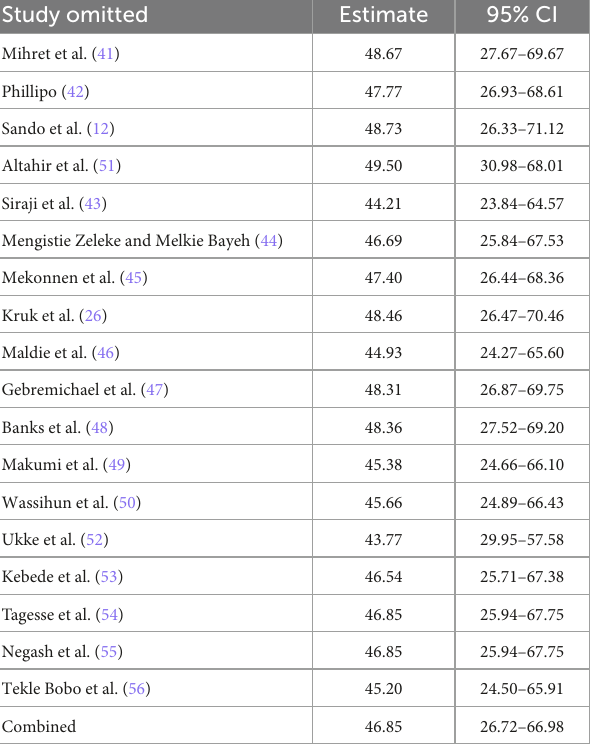
TABLE 3 The pooled prevalence of disrespect and abuse of women during childbirth in East Africa when one study omitted from the analysis a step at a